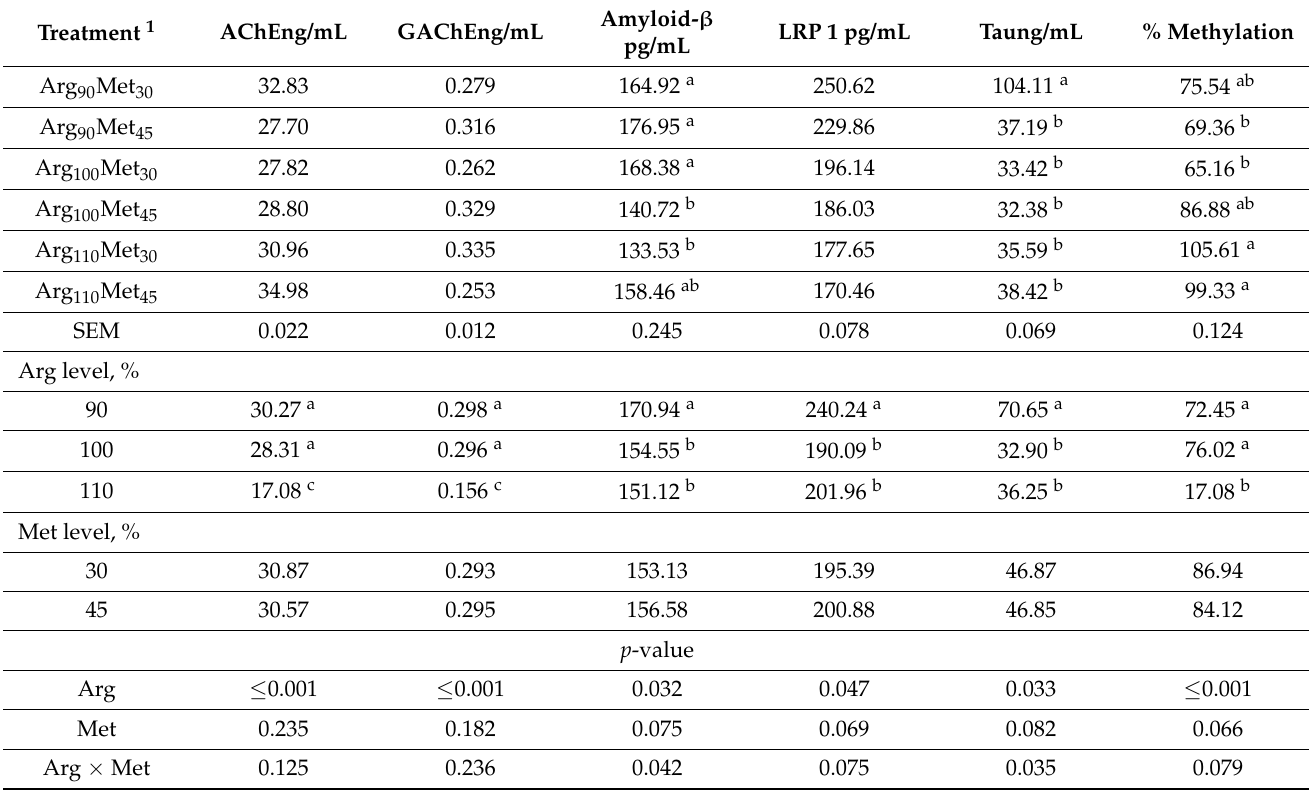
Table 6. Indicators of neurodegenerative changes in the brain of turkeys, Experiment 2.